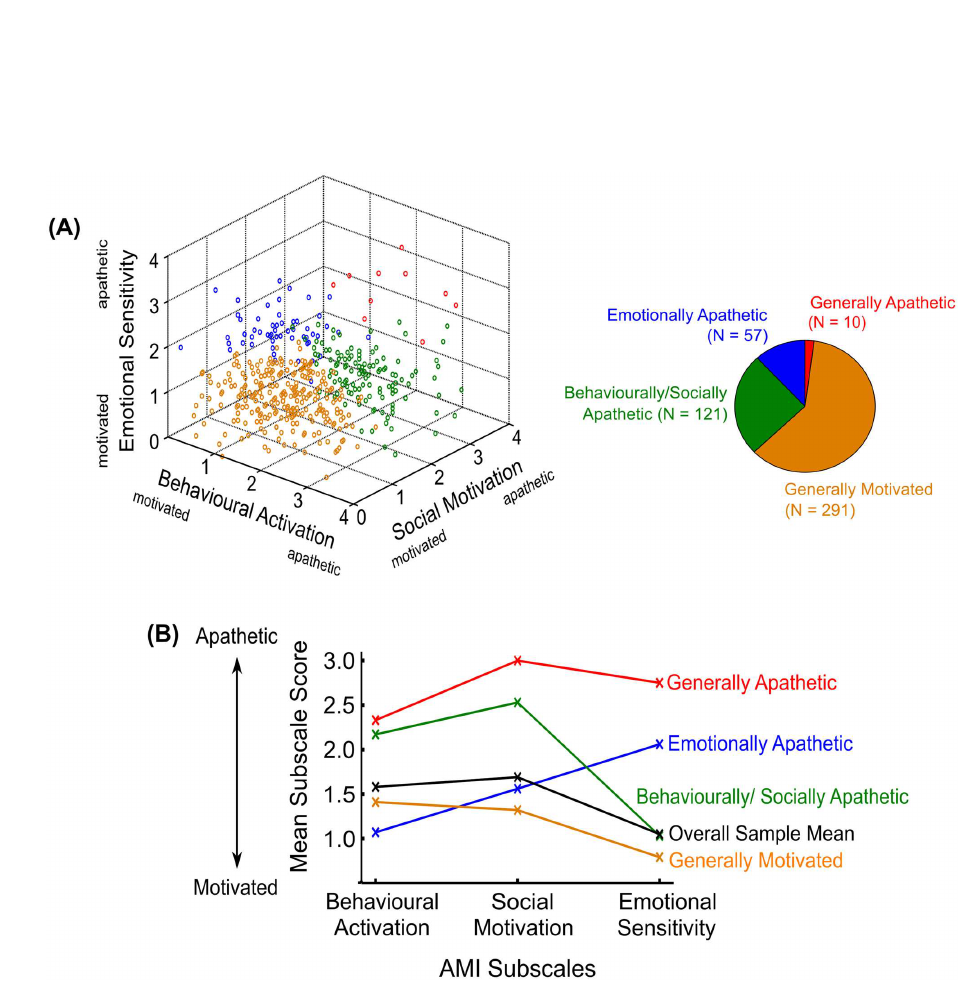
Fig 3. Distribution of apathy along the AMI subscales and conditional response means of the 4-class solution. The AMI consists of three subscales: BehaviouralActivation, Social Motivation and Emotional Sensitivity.Every subscalecontains6 items that is each scored from 0–4, with a highermean score indicating greater apathy. (A) 3D scatterplot illustratingthe distribution of each healthyindividual’smean rating along the three AMI subscales. The four classes were labelledgenerallymotivated (orange),behaviourally/socially apathetic (green), emotionally apathetic(blue), and generallyapathetic (red). (B) Conditional responsemean value greater than overall sample means (black line) indicatesapathy on that AMI